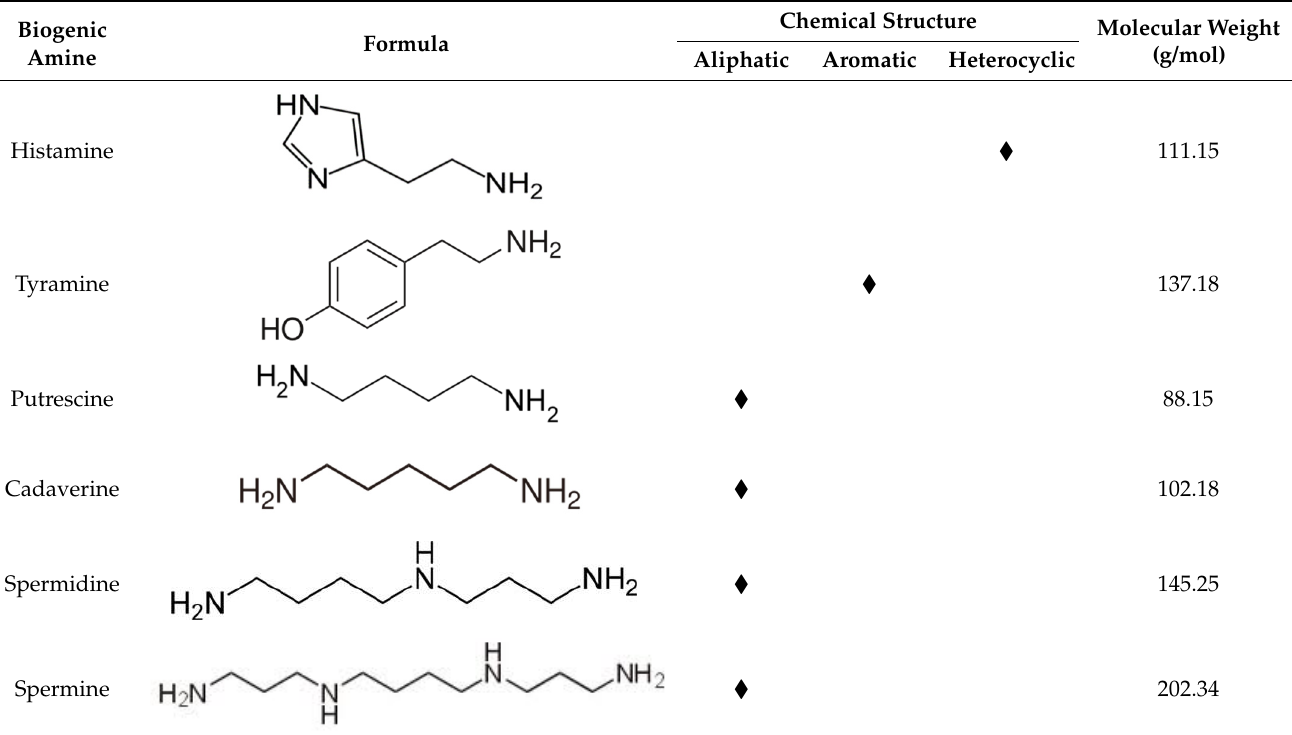
Table 1. Formula and chemical structure of most common BAs in beverages.